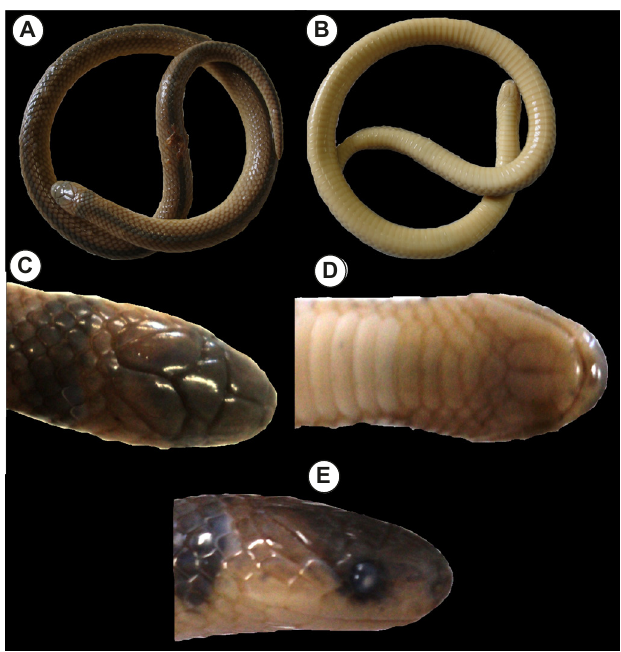
Figure 1. Head views of the specimen (CHR 023)